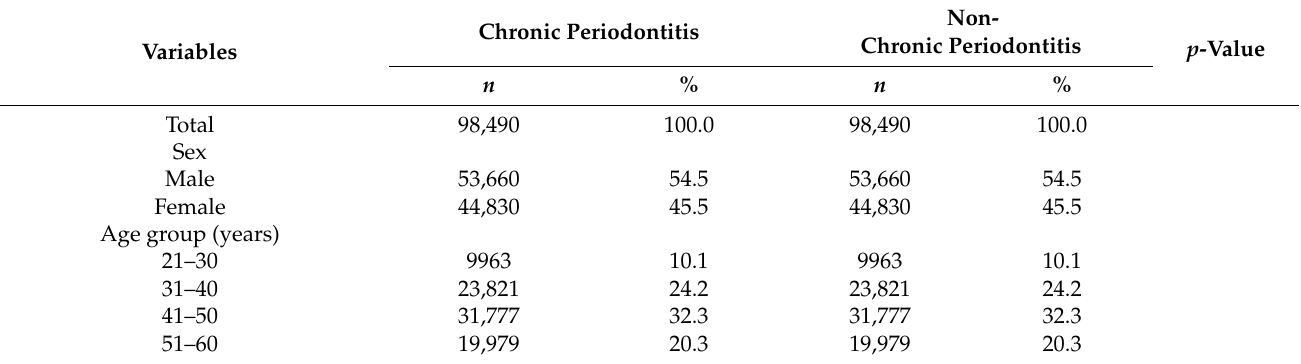
Table 1. Demographic distribution according to chronic